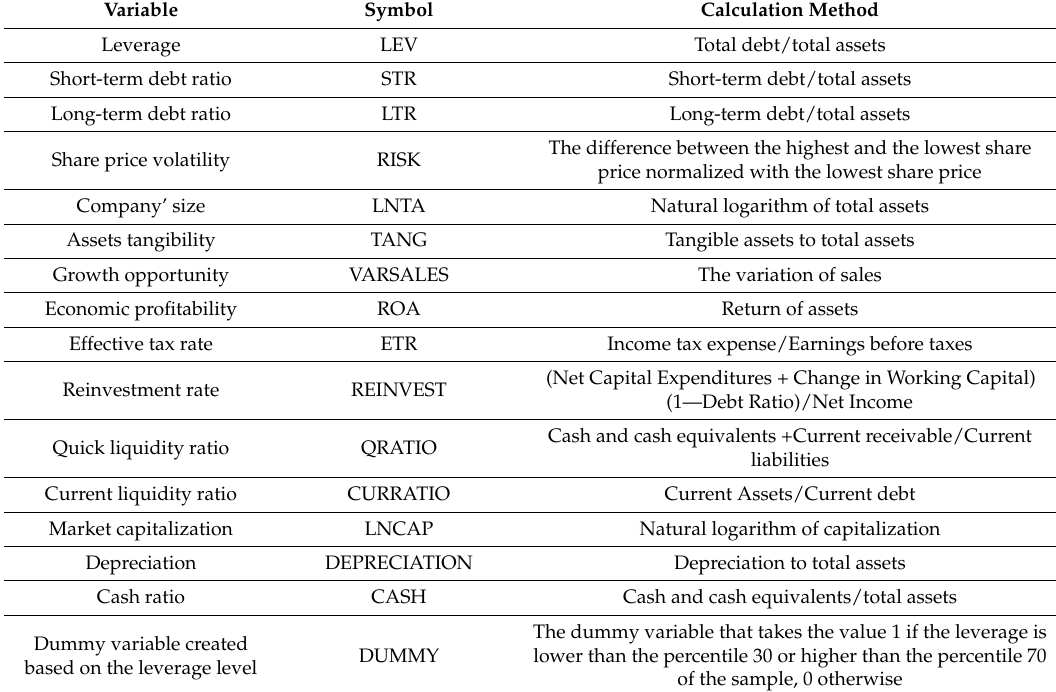
Table 5. Variables employed in the empirical